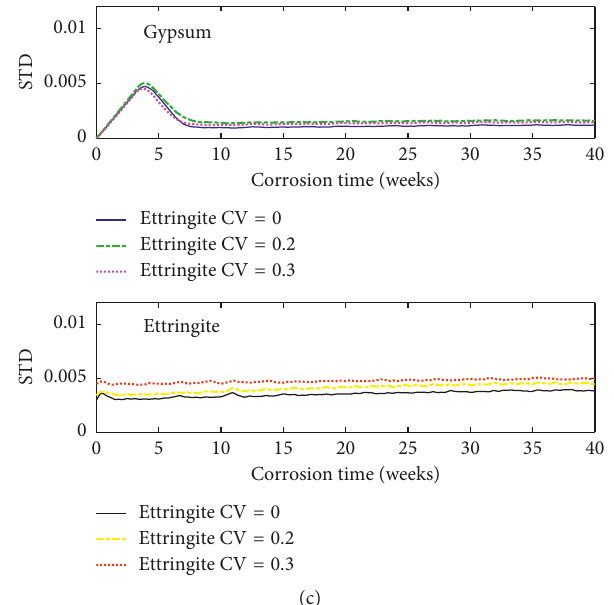
Figure 13: Concentration STDs of the corrosion products affected by the variations of the initial concentrations of (a) sodium sulfate, (b) gypsum, and (c) ettringite.